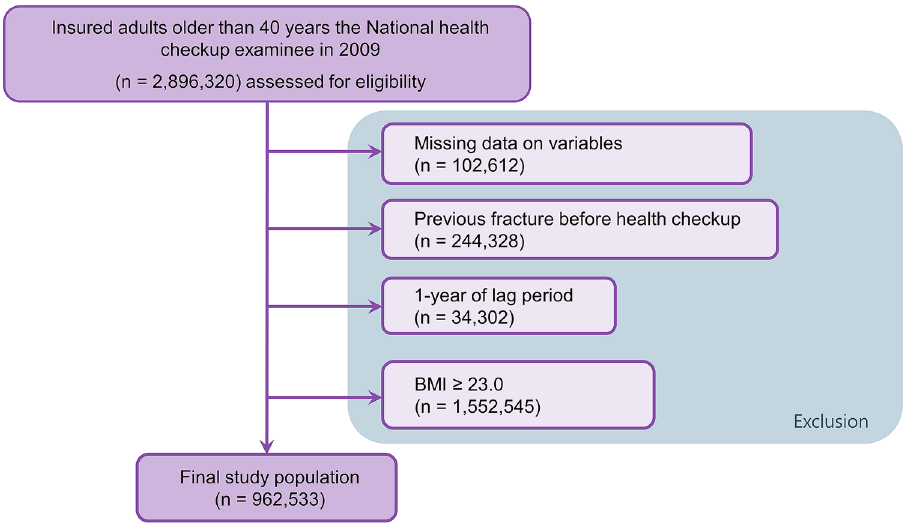
Figure 1. Flow chart of the study population. BMI body mass